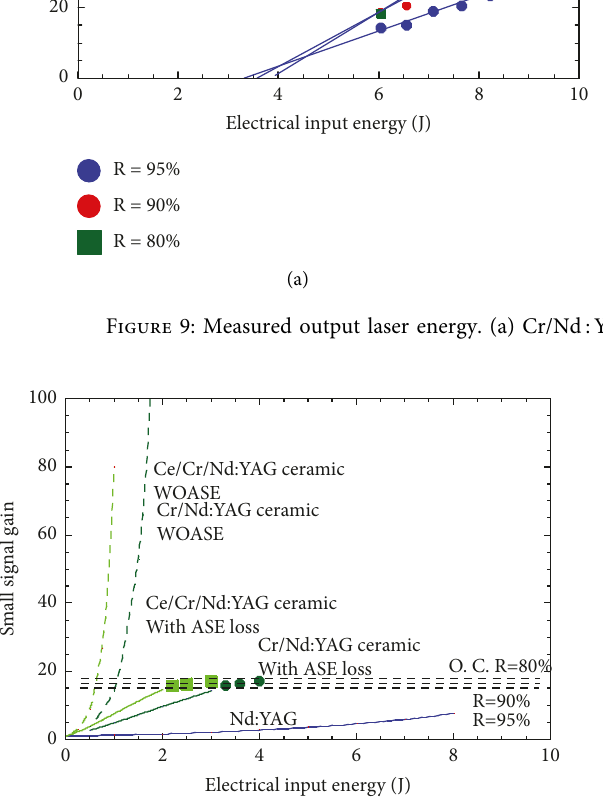
Figure 10: Calculated laser gain at lasing